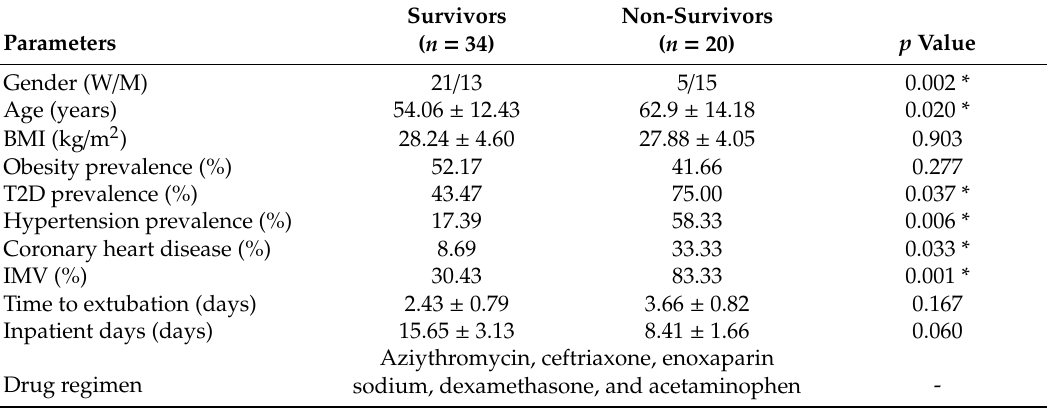
Table 1. Demographic and clinical characteristics in hospitalized patients with severe